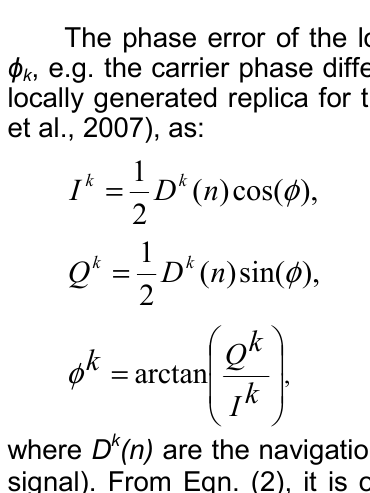
Figure 2 – The block diagram of the Costas PLL Slika 2 – Blok-dijagram Costasove PLL Рис . 2 – Блок диаграмм Costas